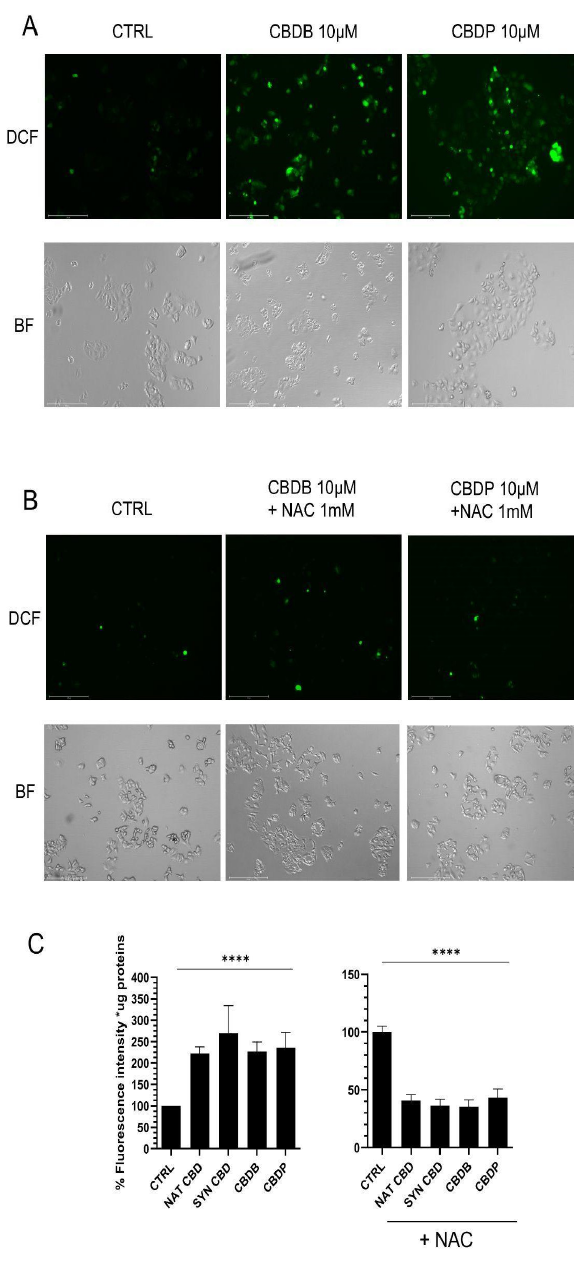
Figure 3. Representative fluorescent images of 2 (cid:48) ,7 (cid:48) -dichlorodihydrofluorescein diacetate (DCFH-DA) staining in MCF-7 cells. ( A ) MCF-7 cells treated for 24 h with vehicle (DMSO), CBDB or CBDP (10 µM). ( B ) MCF-7 cells treated with CBDB or CBDP (10 µM) and 1 mM N-acetylcysteine (NAC), for 24 h. All images were taken by Evos m7000 fluorescence microscope objective 10x, scale bar 275 µm. ( C ) Fluorescence intensity quantification by a fluorescence microplate reader for DCFH-DA staining in MCF-7 cells control and after CBD, and NAC+ CBD homologs, lafter 24 h. Values are the mean ± SD. **** p < 0.0001 compared with controls.